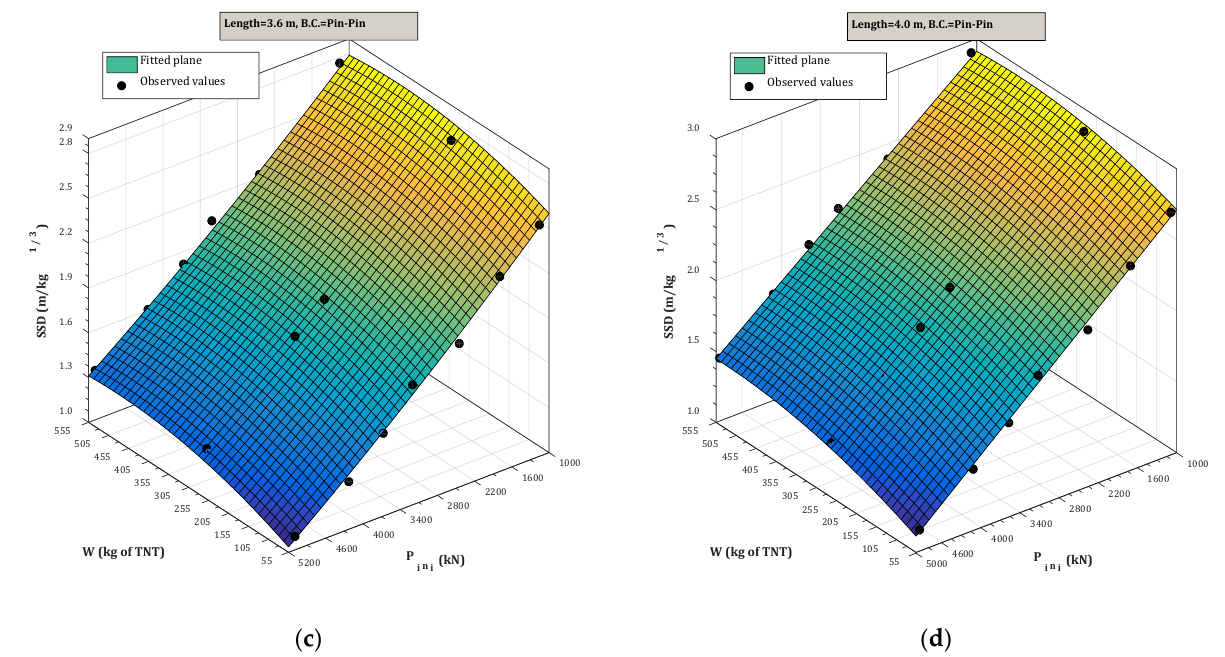
Figure 9. SSD values for steel columns with pinned ends and different lengths: ( a ) L = 2.8 m, ( b ) L = 3.2 m, ( c ) L = 3.6 m and ( d ) L = 4.0 m.